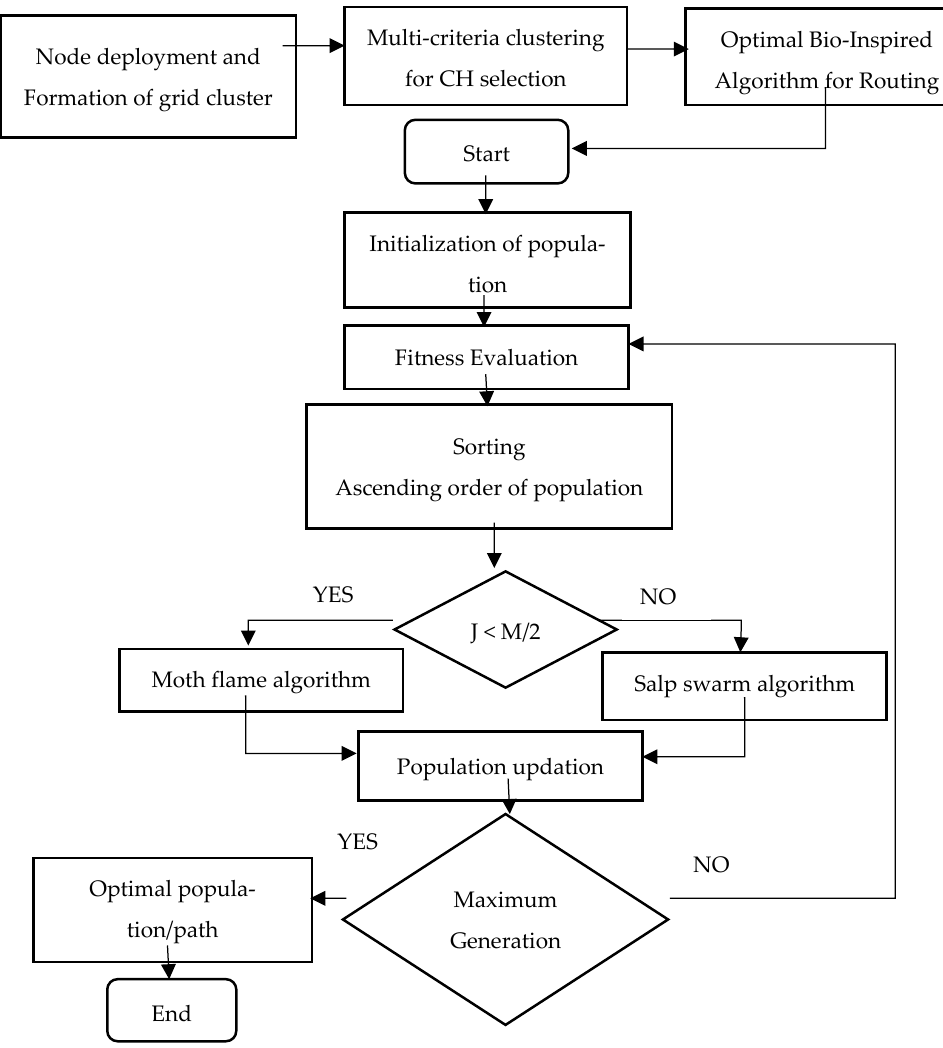
Figure 1. Flow diagram of the proposed approach.